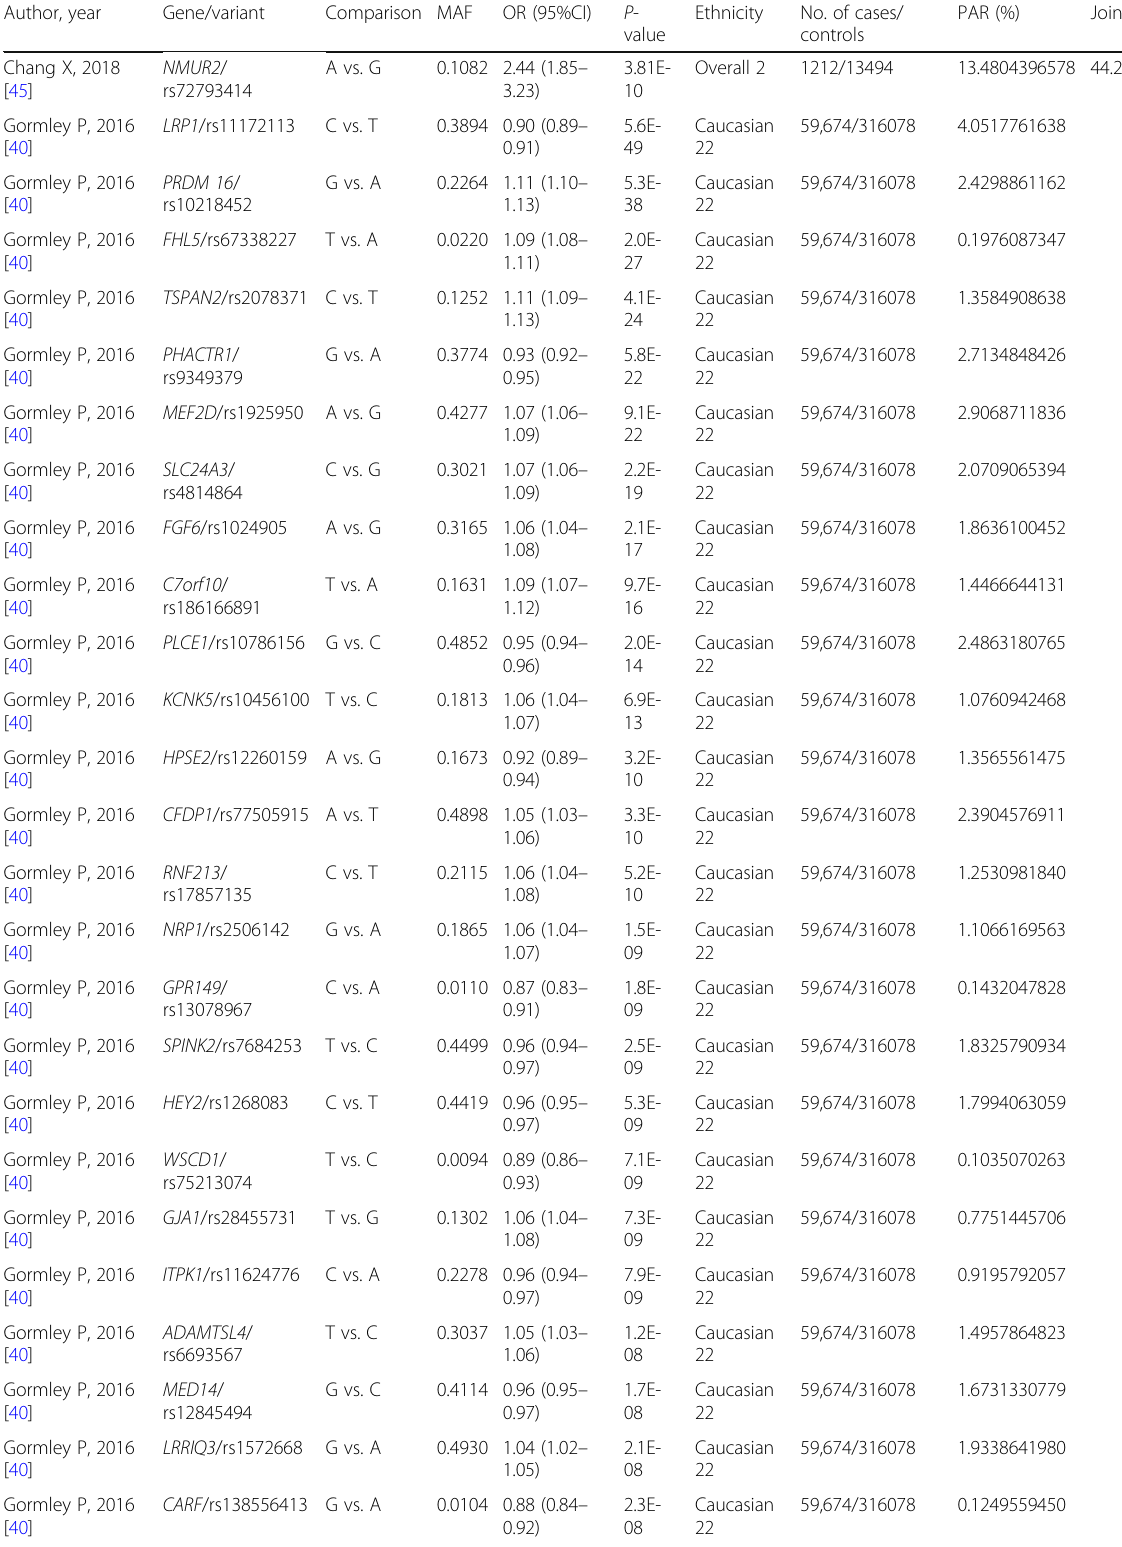
Table 6 Combination of genetic polymorphisms to predict risk of migraine. Calculation of joint PAR% using the SNPs showing noteworthiness during the computing of BFDP (BFDP < 0.8) or FPRP (FPRP< 0.2) at a statistical power to detect the OR of